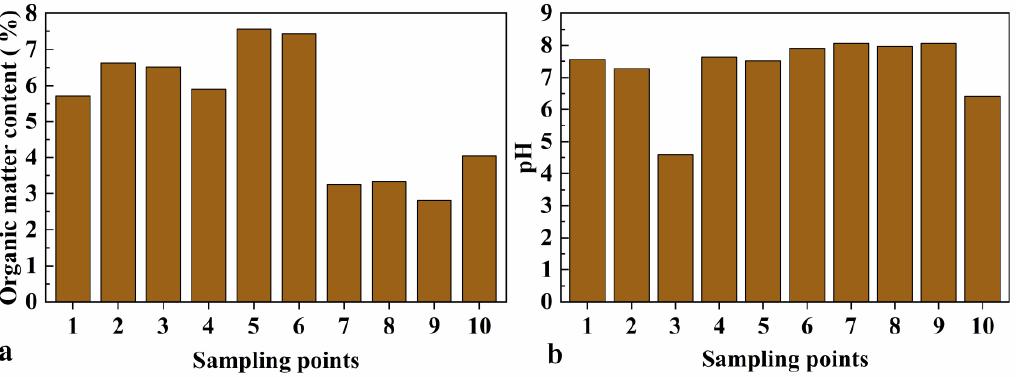
Figure 2. Physical and chemical properties of soil samples. ( a ) Organic matter content of sampling points. ( b ) pH of sampling points. (sampling points: (1, 3, 5, 6) pak choi, (2) rice; (4) spring onion; (7, 10) radish; (8) Chinese cabbage; (9) Chrysanthemum coronarium ).